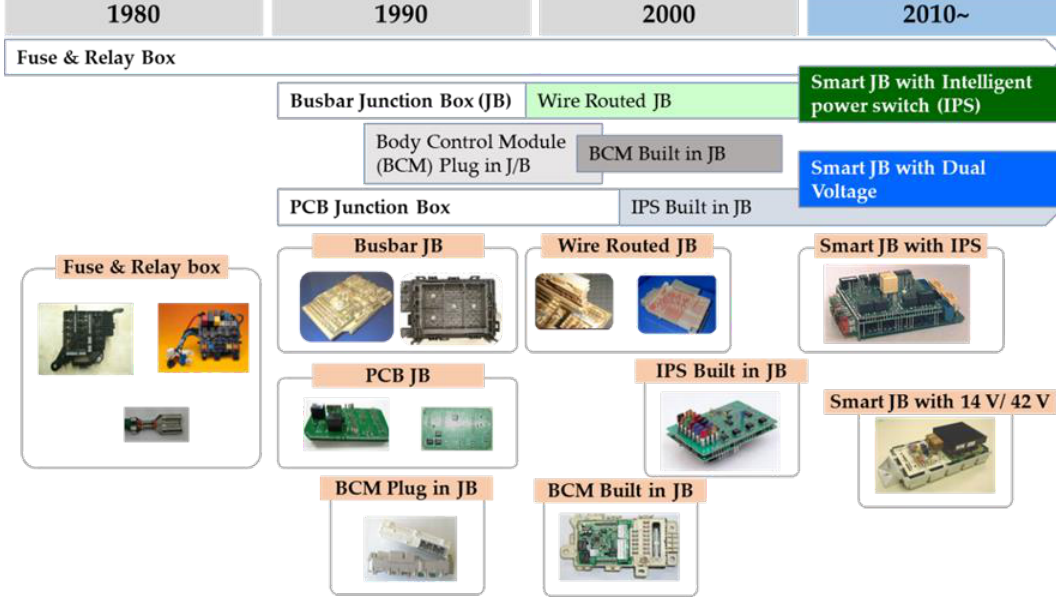
Figure 1. Timeline showing the evolution of JBs to SJBs.